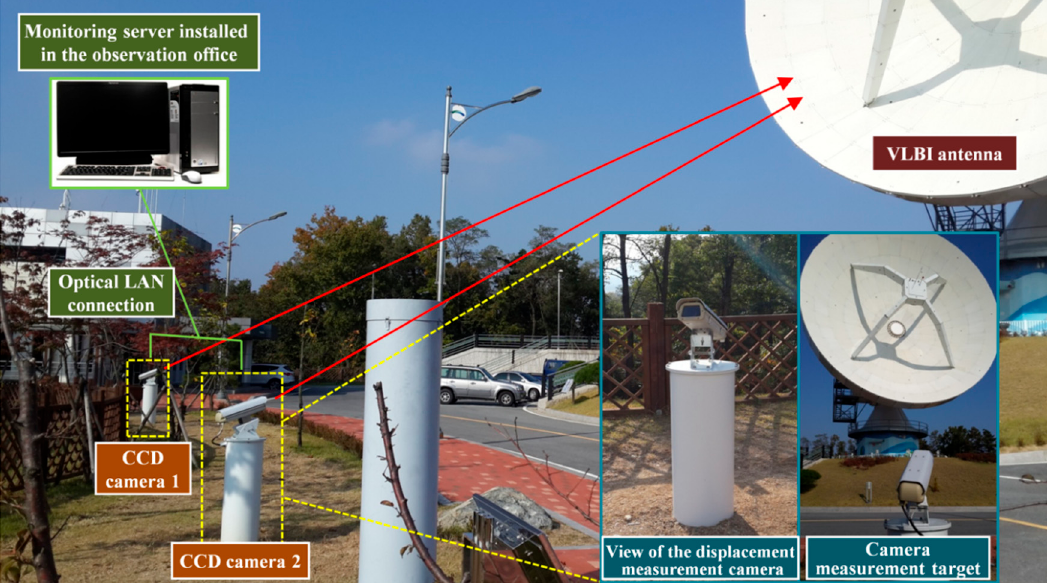
Figure 3. The components of the process for measuring static displacement of the VLBI antenna surface using close-range photogrammetry at the SGOC.